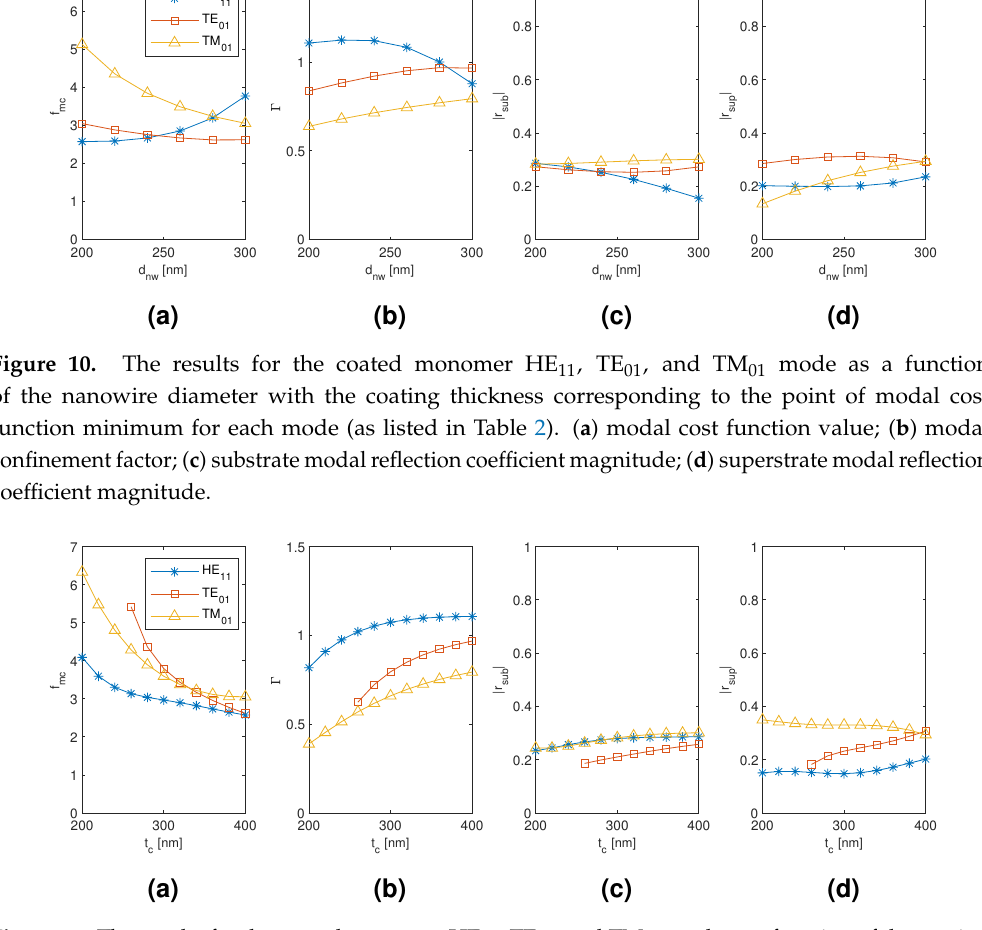
Figure 11. The results for the coated monomer HE 11 , TE 01 , and TM 01 mode as a function of the coating thickness with the nanowire diameter corresponding to the point of modal cost function minimum for each mode (as listed in Table 2). ( a ) modal cost function value; ( b ) modal confinement factor; ( c ) substrate modal reflection coefficient magnitude; ( d ) superstrate modal reflection coefficient